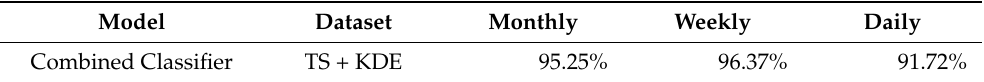
Table 4. Comparison of the classification accuracies of the power generation of photovoltaic systems of the Combined Classifier for different input spans.